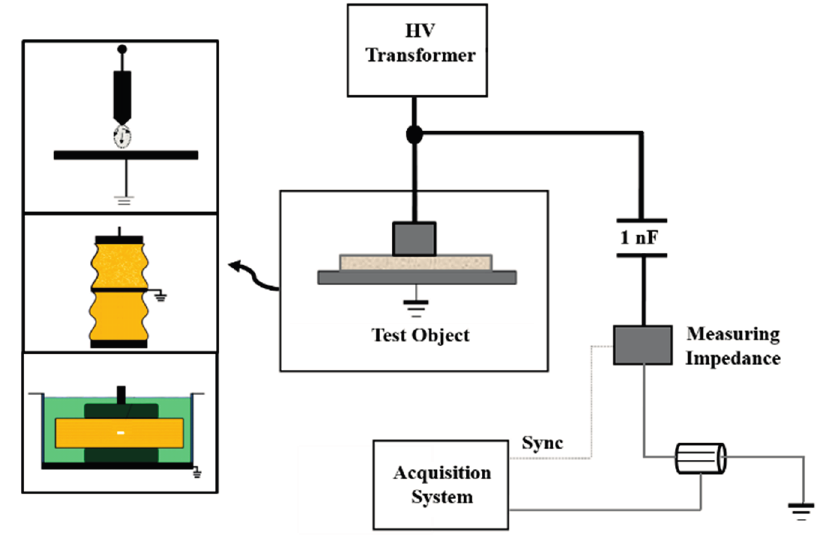
Figure 3. Experimental setup for PD